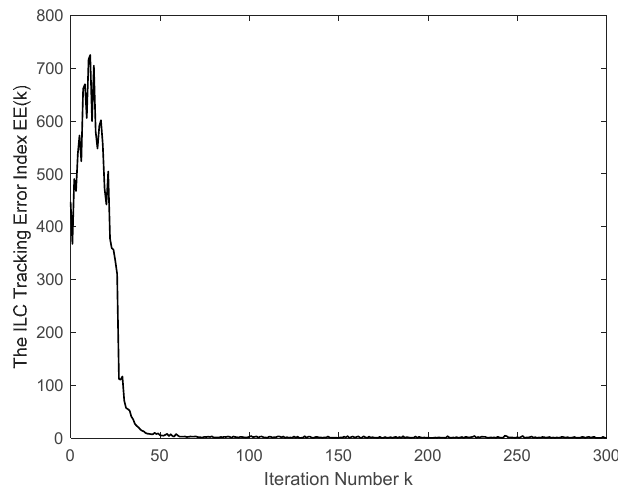
Figure 5. Tracking error index EE ( k ) of different iterations.